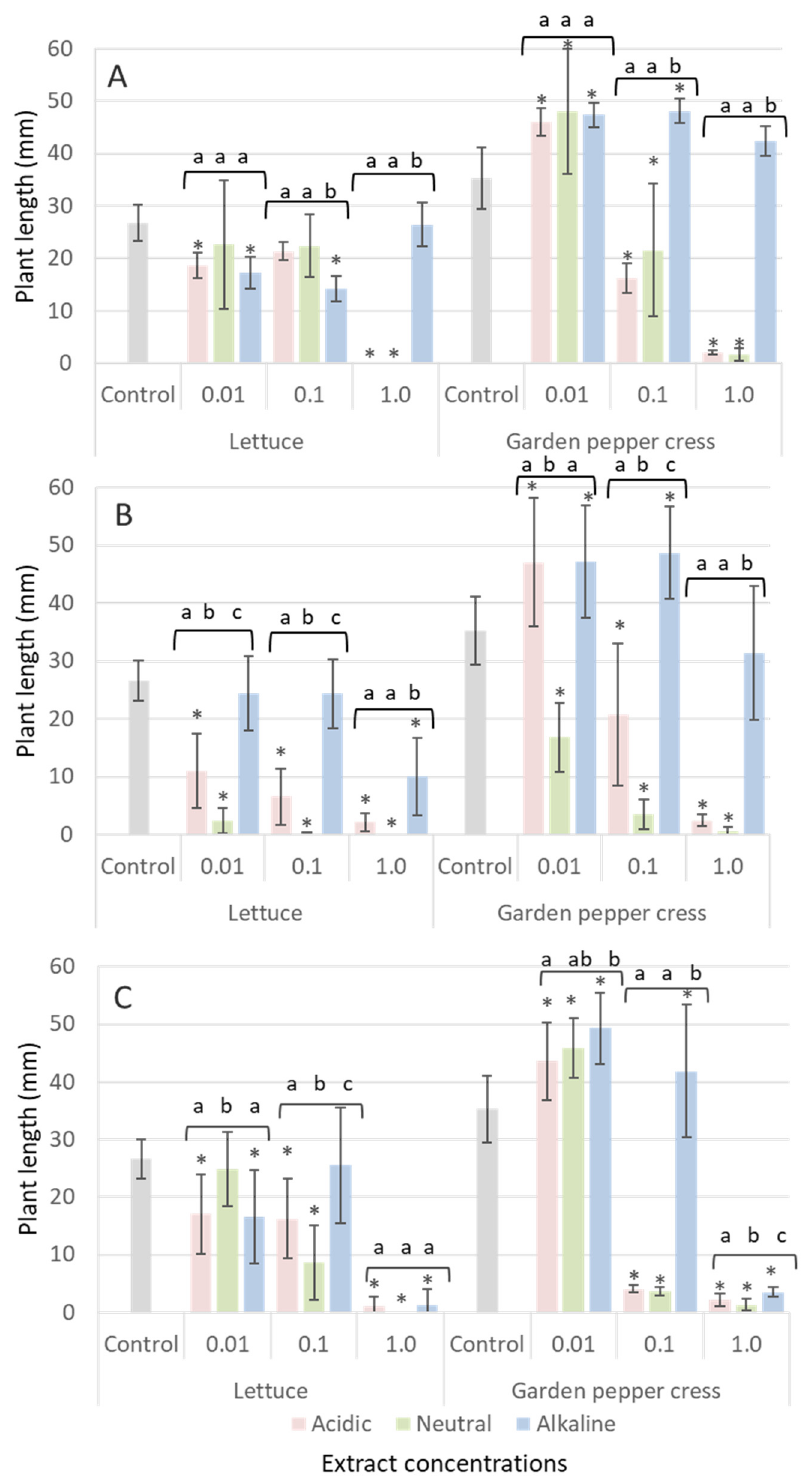
Figure 1. Inhibitory effect of S. canadensis water/diethyl ether extracts (acidic, neutral and alkaline fractions at 0.01, 0.1 and 1.0 relative concentration ranges) of roots ( A ), leaves ( B ) and inflorescence ( C ) on germination and growth (mm) of lettuce ( Lactuca sativa ) and garden pepper cress ( Lepidium sativum ) (one-way ANOVA test, df = 9, p < 0.05). Data are presented as means of treatments (n = 60) ± SD (bars); asterix (*) indicates statistically significant difference compared to the control; letters (a, b and c) denote statistically significant difference between fractions (Tukey’s test, df = 2, p < 0.05).